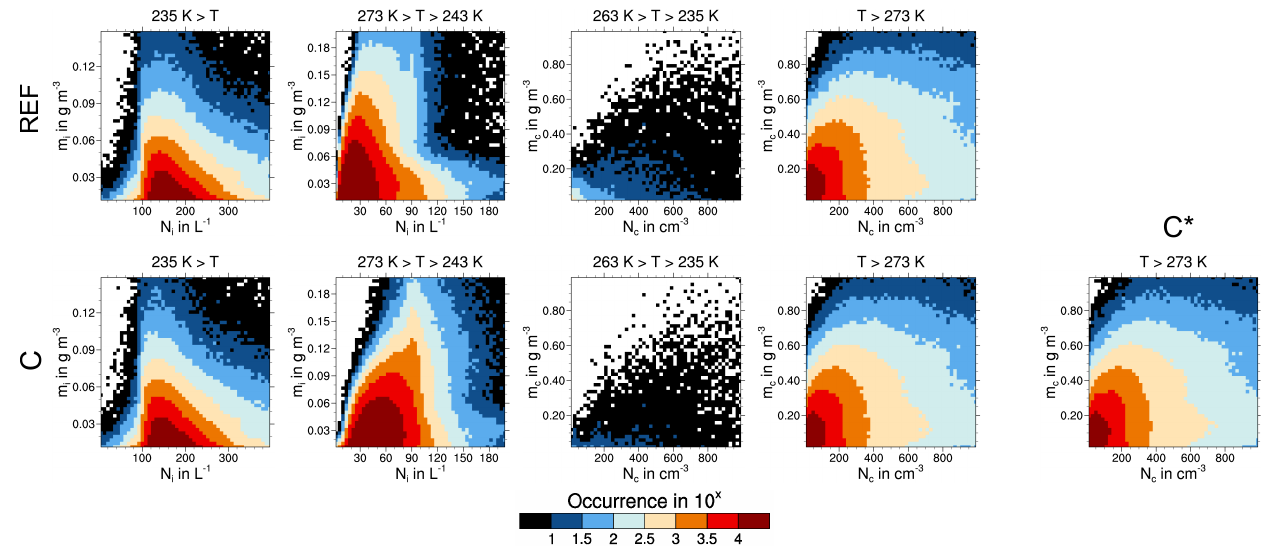
Fig. 7. Domain wide joint histogram of number and mass concentrations for cloud droplet (column 3 to 5) and ice crystals (column 1 to 2) calculated for grid points with N d ≥ 1cm − 3 and different temperatures ranges for 26–29 May 2008. The top row shows results from simulation REF. The bottom row shows results from simulations C and C ∗ (right figure).